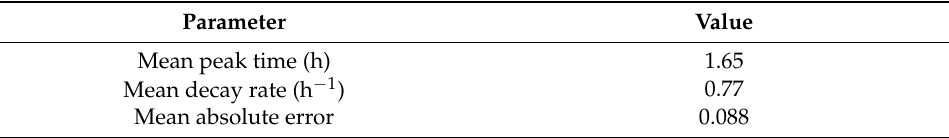
Figure 9. Mean, min, and max prediction errors for the individuals computed at each epoch by the genetic algorithm for the same patient in Figure 5 generated by the AIDA2 simulator. Table 4. Average results.